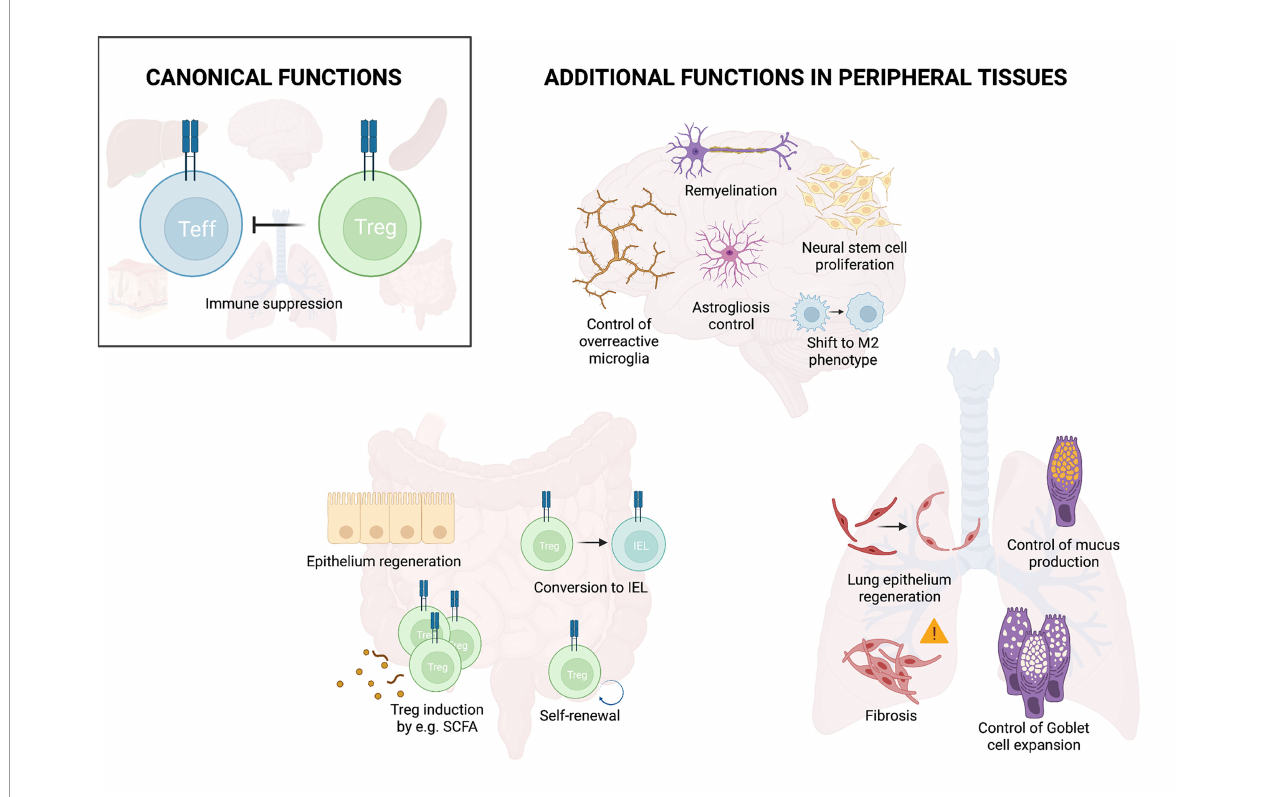
FIGURE 2 | Treg functions in peripheral tissues. In addition to their main function of suppressing effector immunity, Tregs ful fi ll additional functions in peripheral organs. These include control of overreactive cells and promotion of tissue repair as illustrated for the brain, lung and intestine. Illustration created with